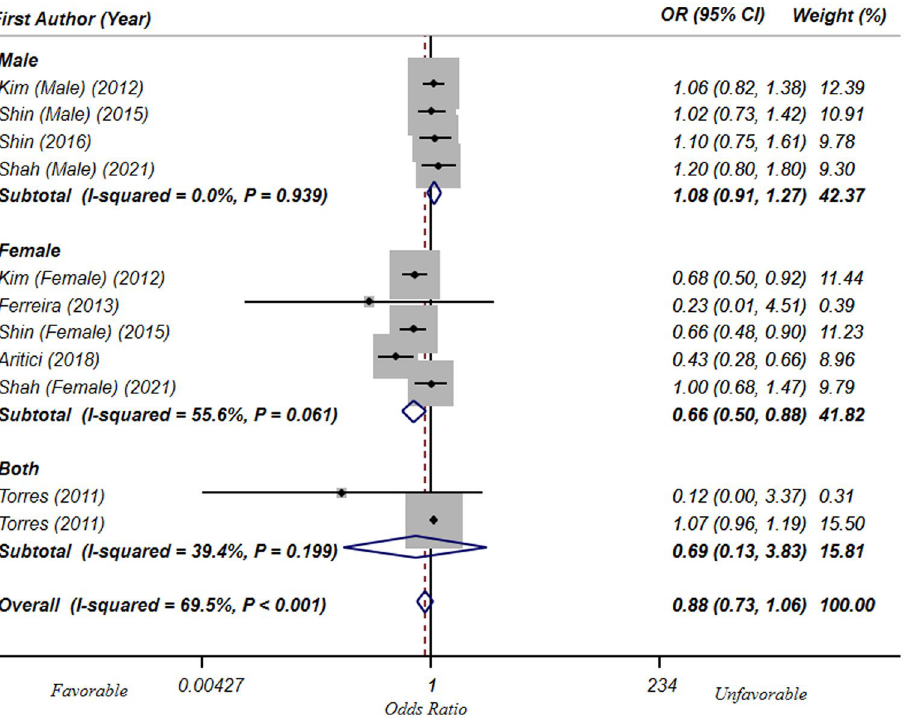
Figure 5. Forest plots of the association of highest vs. lowest level of dietary Ca intake and T2DM/ hyperglycemia in cross-sectional, stratified by